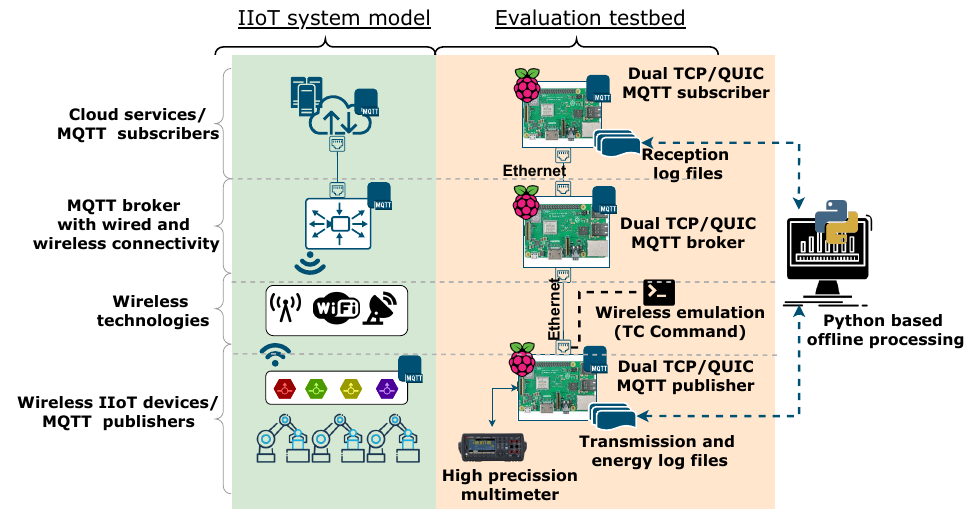
Figure 3. Setup diagram: Raspberry Pi devices taking MQTT